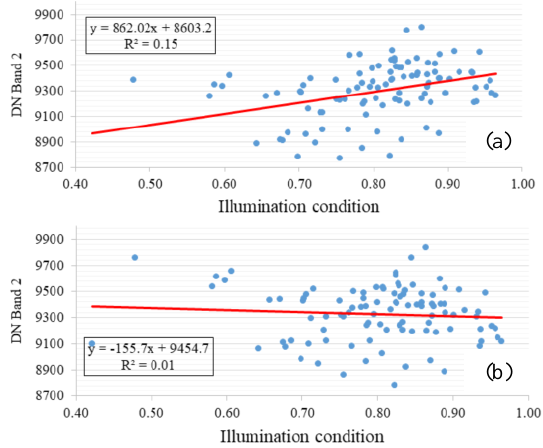
Figure 4. Reflectance of band 2, (a) before and (b) after topographic correction